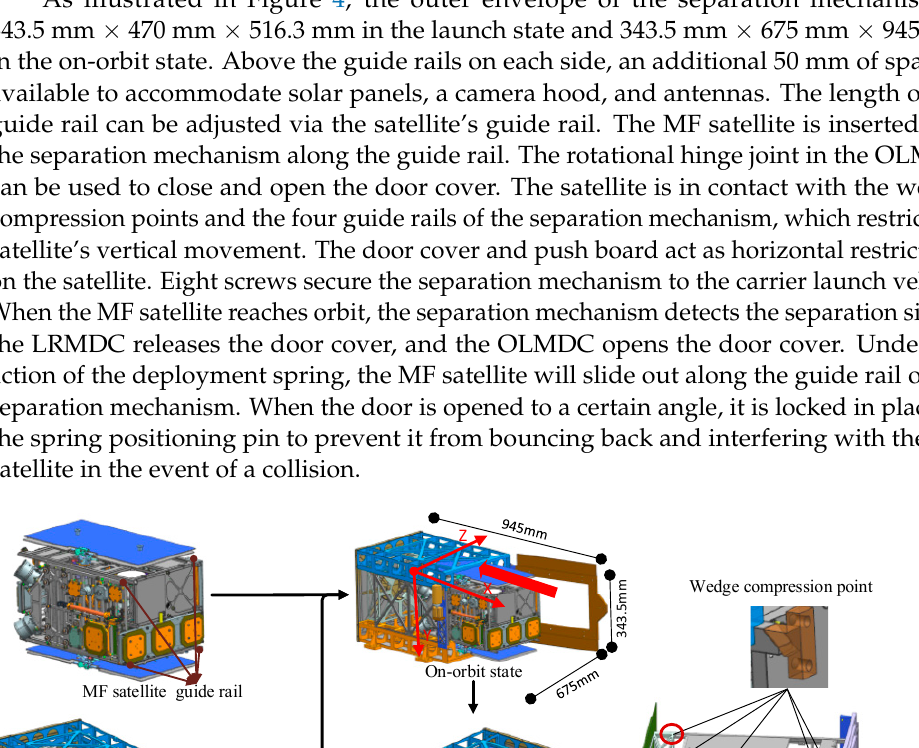
Figure 3. Exploded view of the separation mechanism.